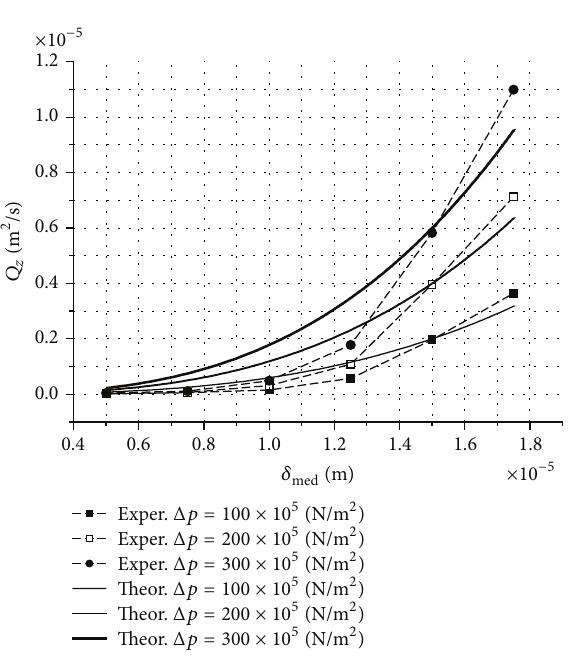
Figure 3: Theoretical and experimental values of 𝑄 𝑧 versus 𝛿 med , with Δ𝑝 astheparameter(experimentalvaluesfrom[3];seeTable